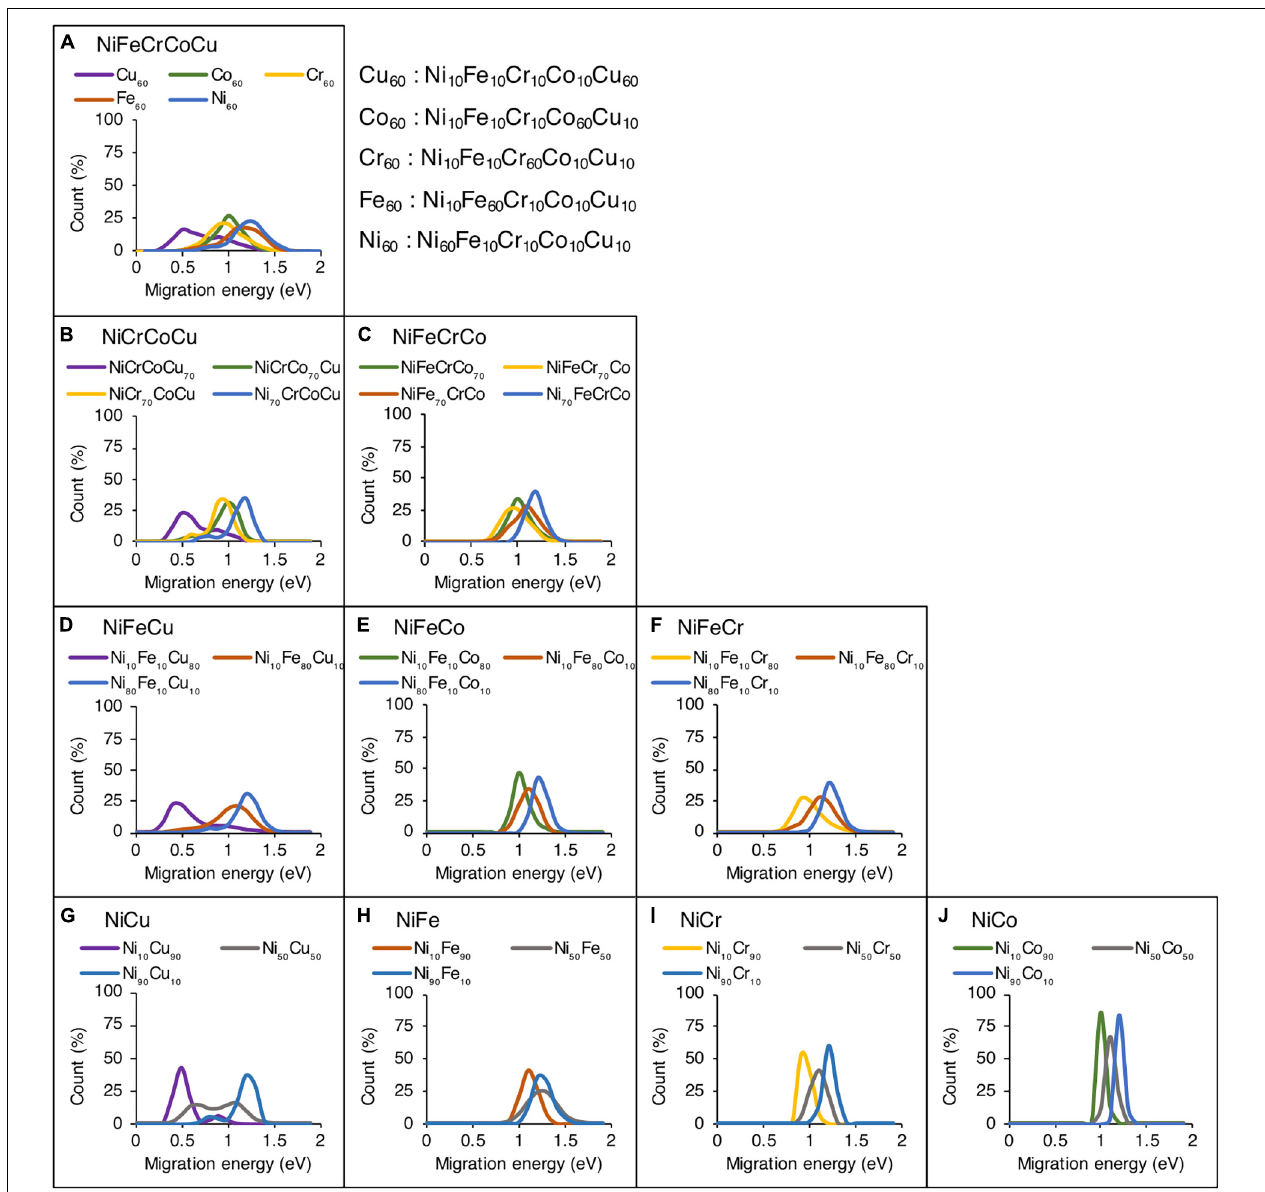
FIGURE 3 | Effect of alloying elemental concentration on vacancy migration energies in (A) quinary, (B,C) quaternary, (D–F) ternary, and (G–J) binary alloys. Only the results of Ni-based alloys are